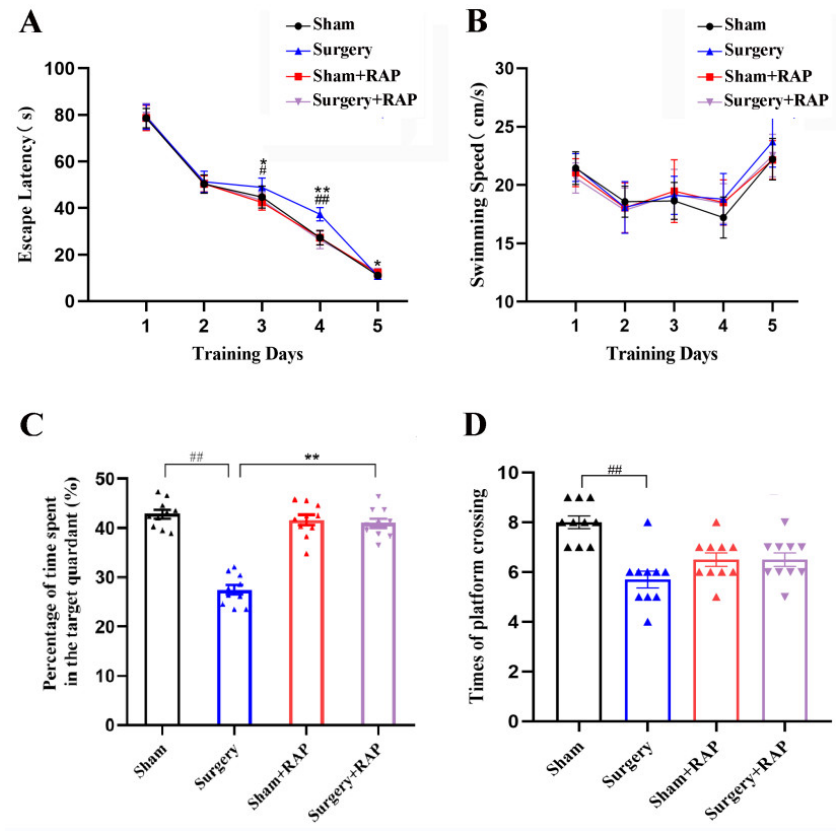
Figure 1. Rapamycin mitigated surgery-induced spatial learning and memory impairments in elderly rats. ( A ) Surgery increased escape latency on days 3 and 4 compared with sham treatment. Rapamycin administration ameliorated surgery-induced escape latency prolongation, but rapamycin alone did not affect escape latency. ( B ) Neither surgery nor rapamycin affected swimming speed. ( C , D ) Surgery decreased both the percentage of dwell time in the target quadrant and number of platform crossings compared with sham treatment. Rapamycin attenuated surgery-induced de- creases in the percentage of dwell time in the target quadrant. Values represent the mean ± SEM, n = 10 per group. # p < 0.05, ## p < 0.01 surgery vs. sham group. * p < 0.05, ** p < 0.01 surgery+rapamycin vs. surgery group. RAP: rapamycin. 3.2. Rapamycin Ameliorated Dysregulation of SNARE and SNARE-Core Proteins Induced by Surgery The surgery group had a significant decrease in high-molecular weight SNAP25 com- plex in their hippocampal synaptosomes compared with the sham group ( p < 0.01; Figure 2A, 2C). We evaluated SNARE-core proteins and found that syntaxin 1A, SNAP25, and VAMP2 protein levels were all sharply reduced in the hippocampal synaptosomes of sur- gery group animals compared with those of sham group animals (all p < 0.01; Figure 2B,D– F). Intriguingly, rapamycin given in advance mitigated the decreased levels of both SNARE and SNARE-core proteins (all p < 0.01; Figure 2A–F).